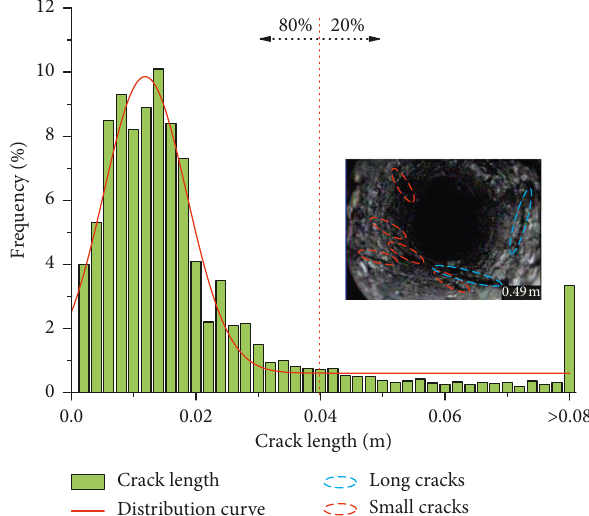
Figure 11: Probability distribution of crack length.